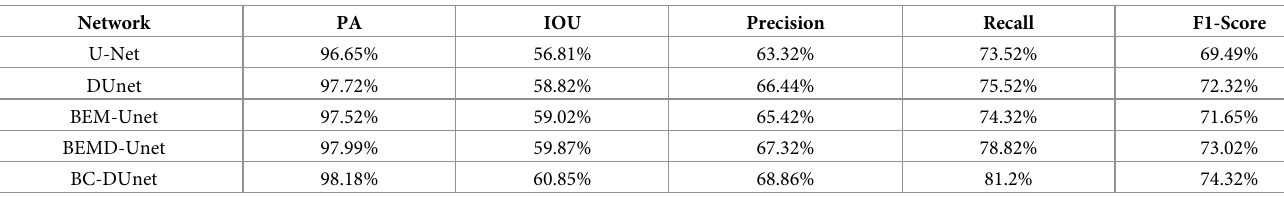
Table 3. Experimental performance comparison table.